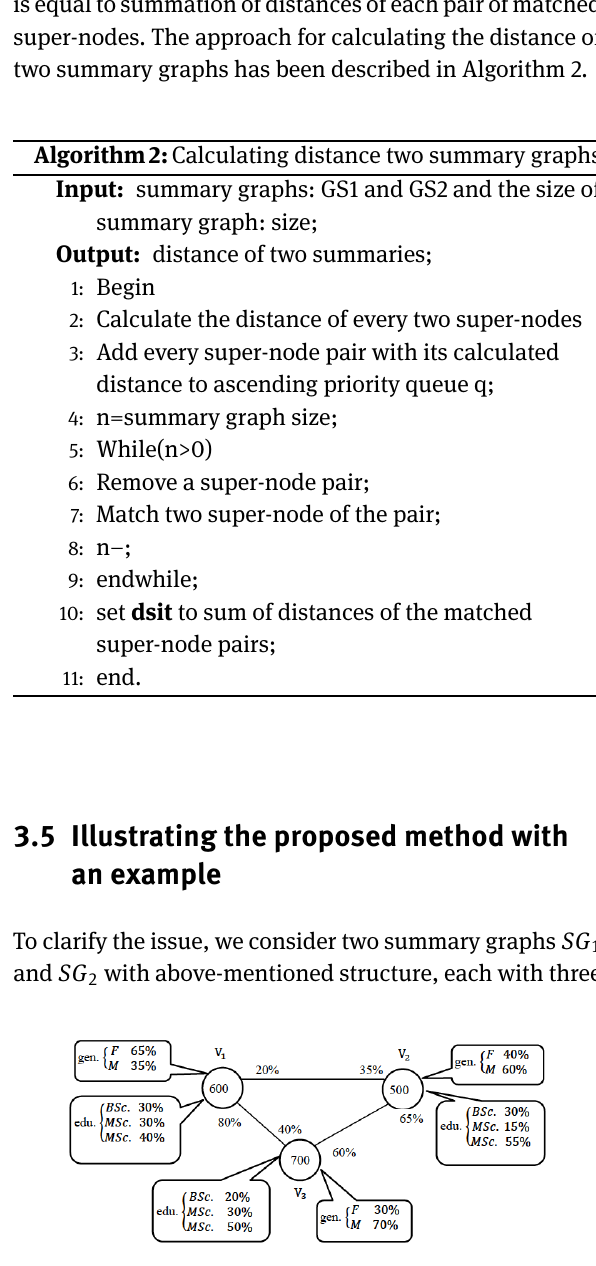
Figure 3: First summary with three super-nodes and two